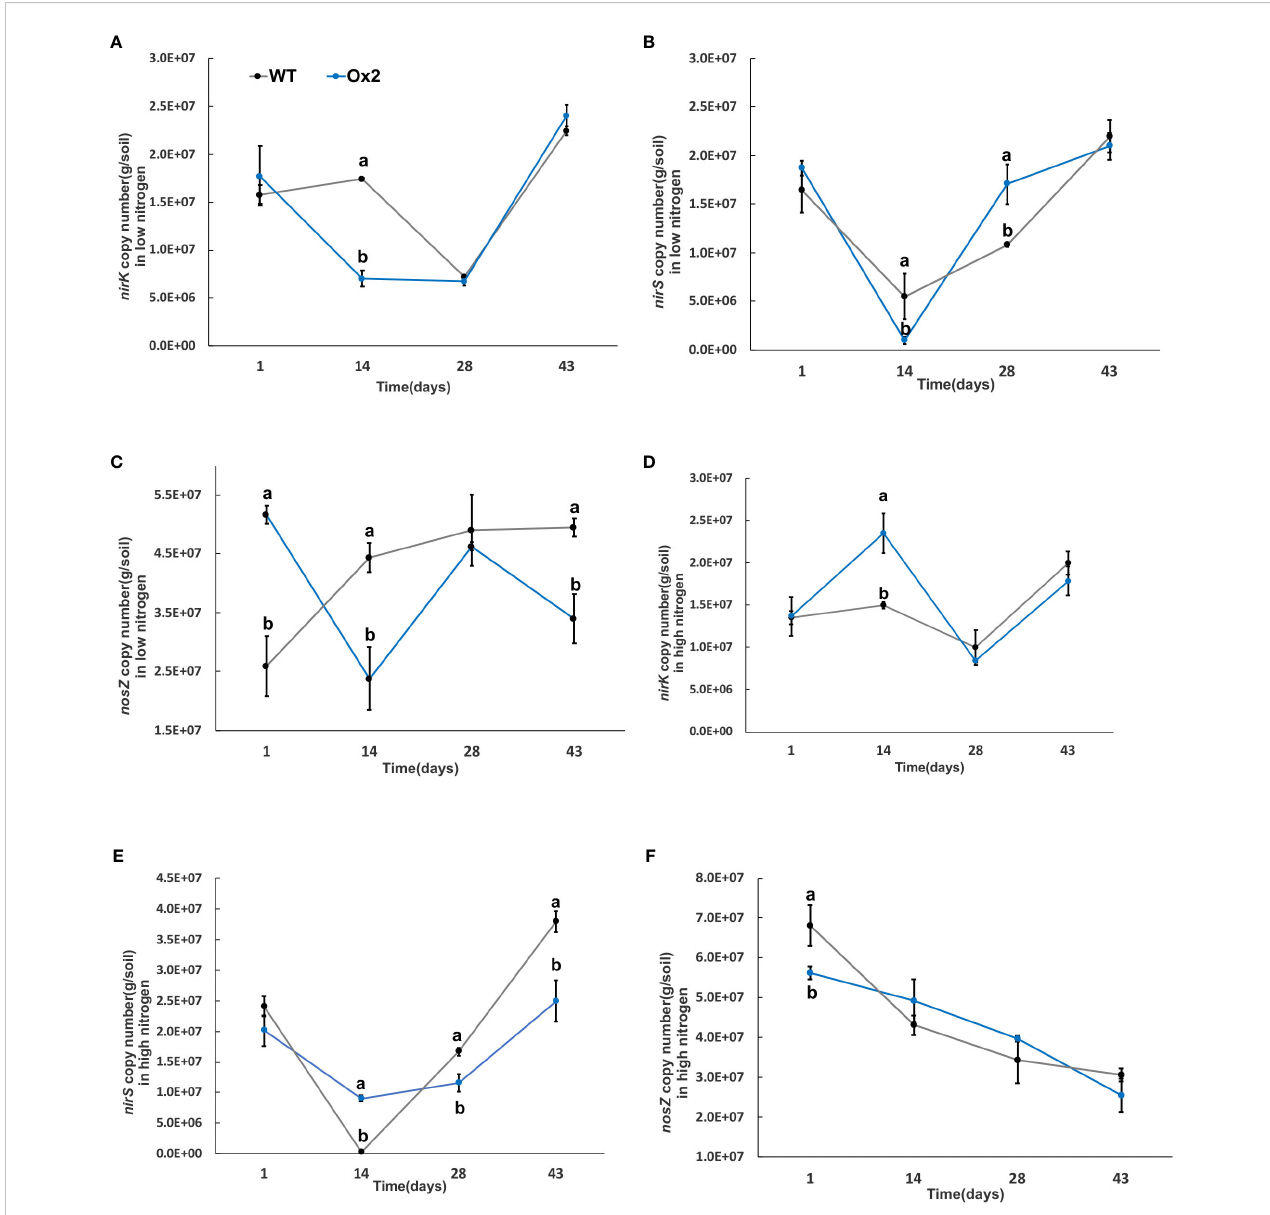
FIGURE 8 The abundance of nirK, nirS and nosZ genes in low and high Nitrogen soil of WT and Ox2. X-axis shows the soil sampling time (days), from the fi rst measurement after transplanting seedlings from nursery to fi eld, Figures (A, D) show the nirK copy number/g of soil in low and high nitrogen application. Figures (B, E) show the nirS copy number/g of soil in low and high nitrogen application. Figures (C, F) show the nosZ copy number/g of soil in low and high nitrogen application Error bars: SE (n = 3). Signi fi cant difference between WT and Ox2 are indicated by different letters: a= high value, b= lower value ( t -test, p<